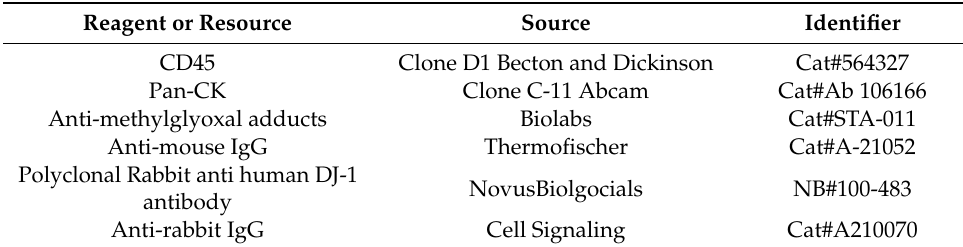
Table 2. Antibodies